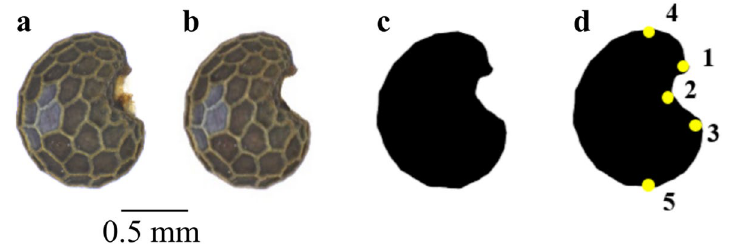
Figure 7. Data acquisition and post-processing (a) Lateral view position; (b) Background removal and cleaning; (c) Mask; (d)